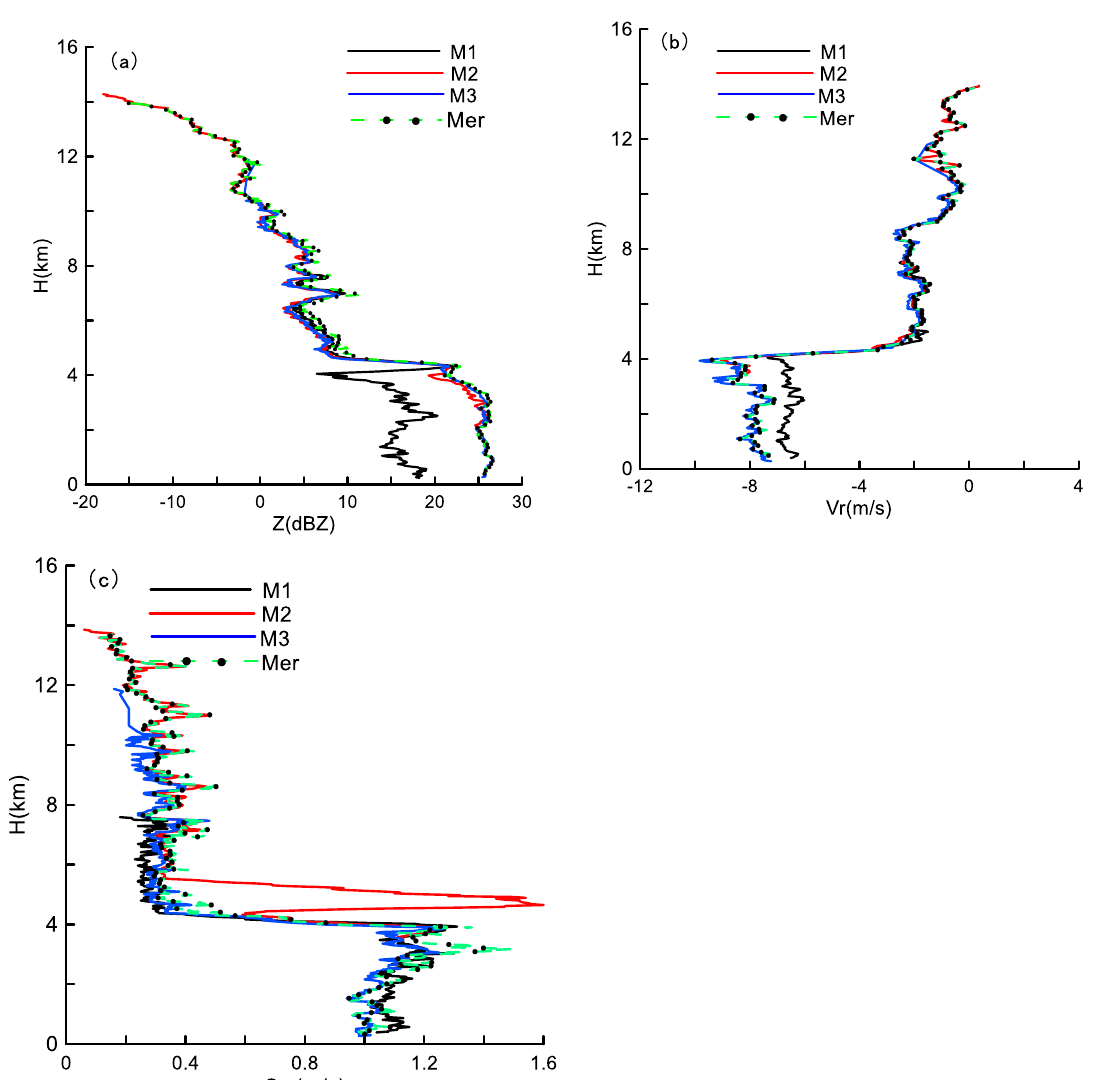
Figure 11. Recalculated ( a ) reflectivity, ( b ) radial velocity, and ( c ) spectral width profiles for modes M1, M2, and M3 and the merged result from SZm for the 30th profile. Note that the spectral width for M2 was calculated before range sidelobe artefacts were removed. The range sidelobe artefacts in M2 are marked by the red arrow. The merged results from SZm are marked as “Mer”.